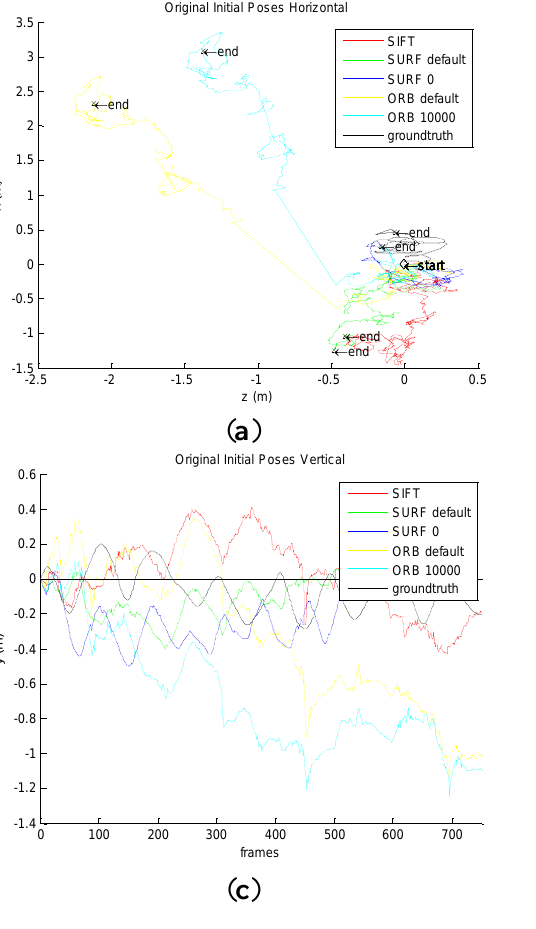
Figure 11. Comparison the original and the improved for Camera pose. ( a ) Horizontal poses for original algorithm; ( b ) Horizontal poses for improved algorithm; ( c ) Vertical poses for original algorithm; ( d ) Vertical poses for improved